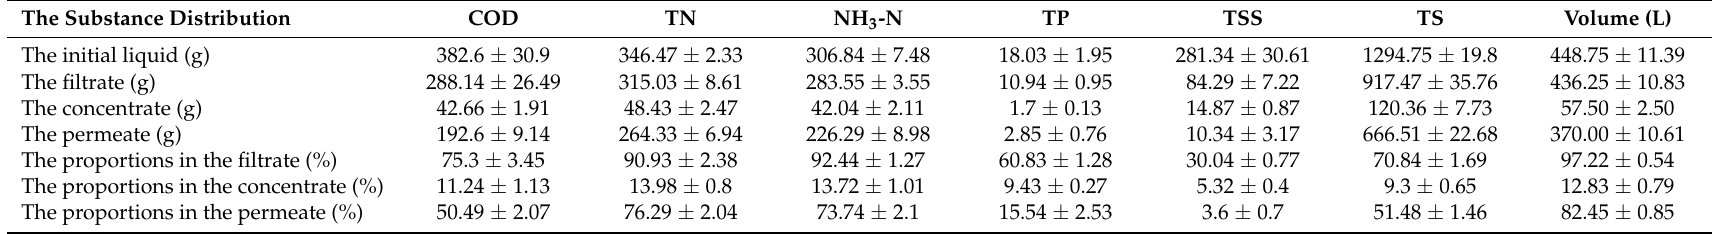
Table 6. The substance flow and distribution of various components in the liquid during the combined process (mean ±